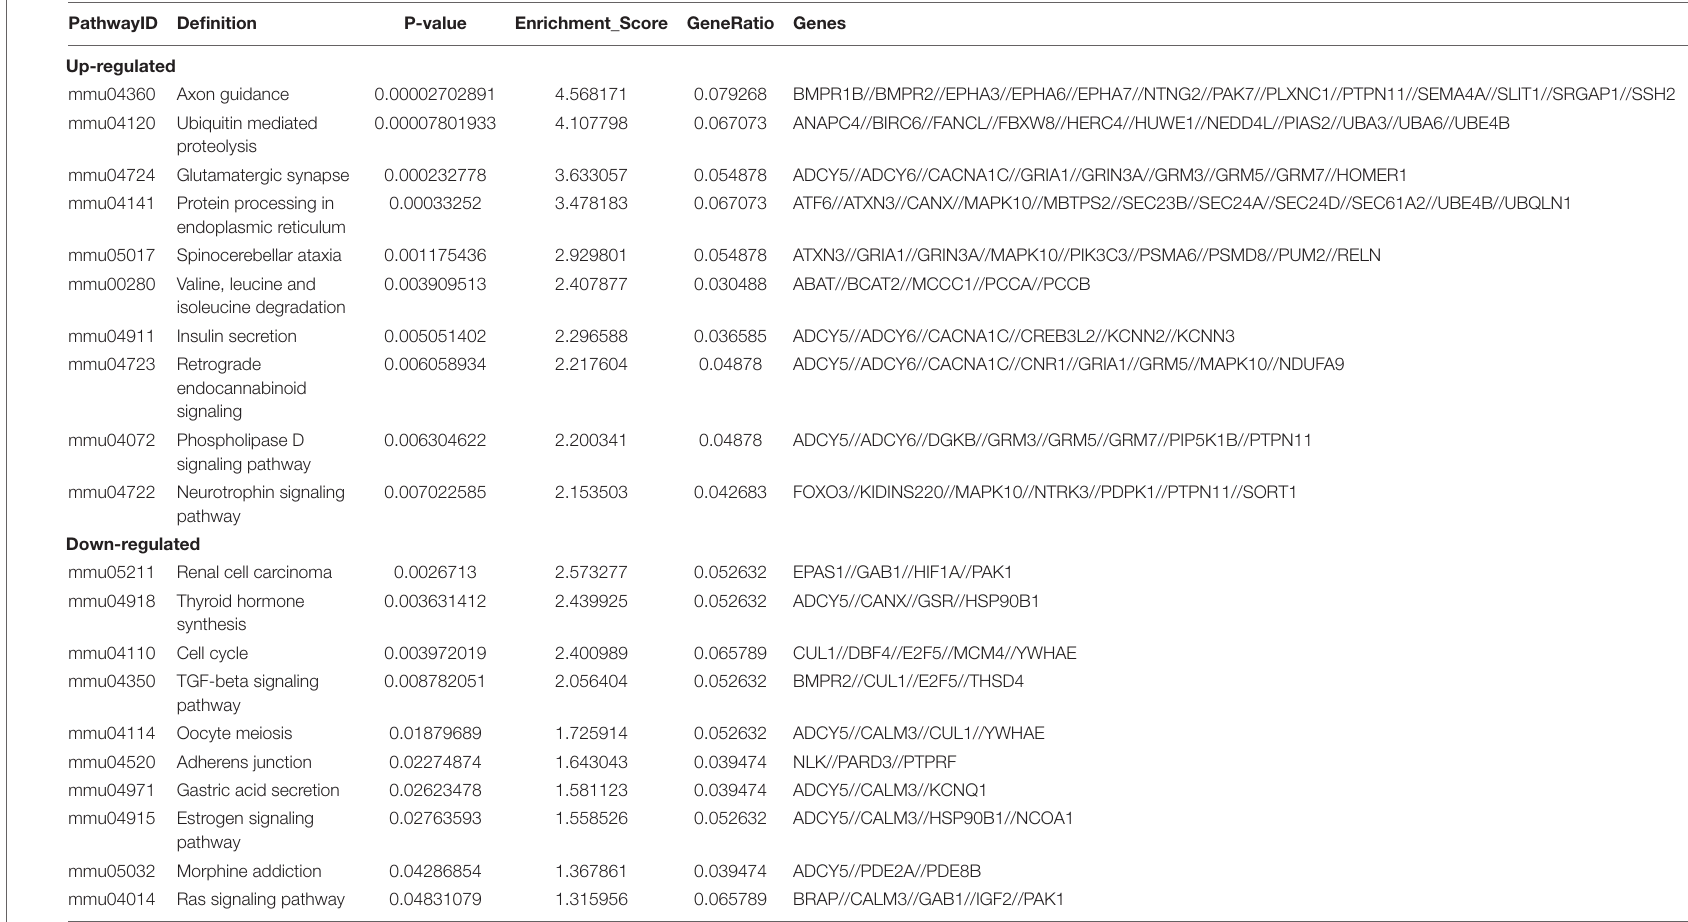
TABLE 4 | Predicted differentially expressed genes in the top ten up-regulated and down-regulated pathways. PathwayID Definition